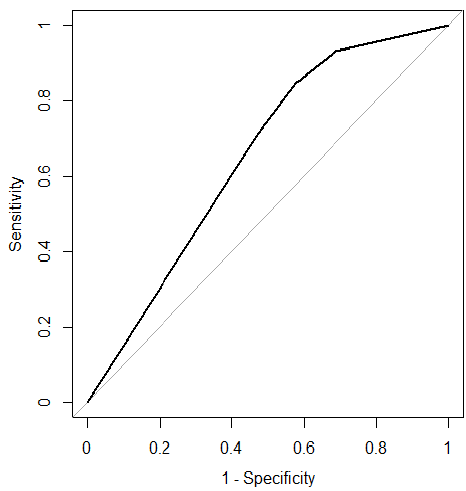
Figure 7. ROC curve for NN (Tanh w/Dropout). (AUC = 0.704, F-score = 0.717).